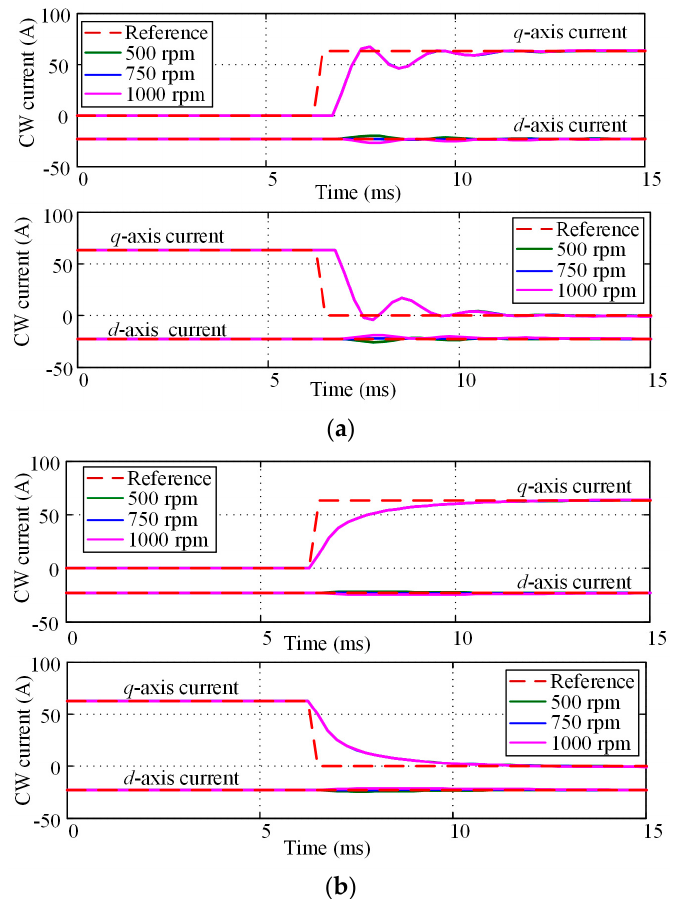
Figure 6. Dynamic responses of the CW current at different speeds (measure (solid); reference (dashed)). ( a ) f samp is 4 kHz; ( b ) f samp is 20 kHz.